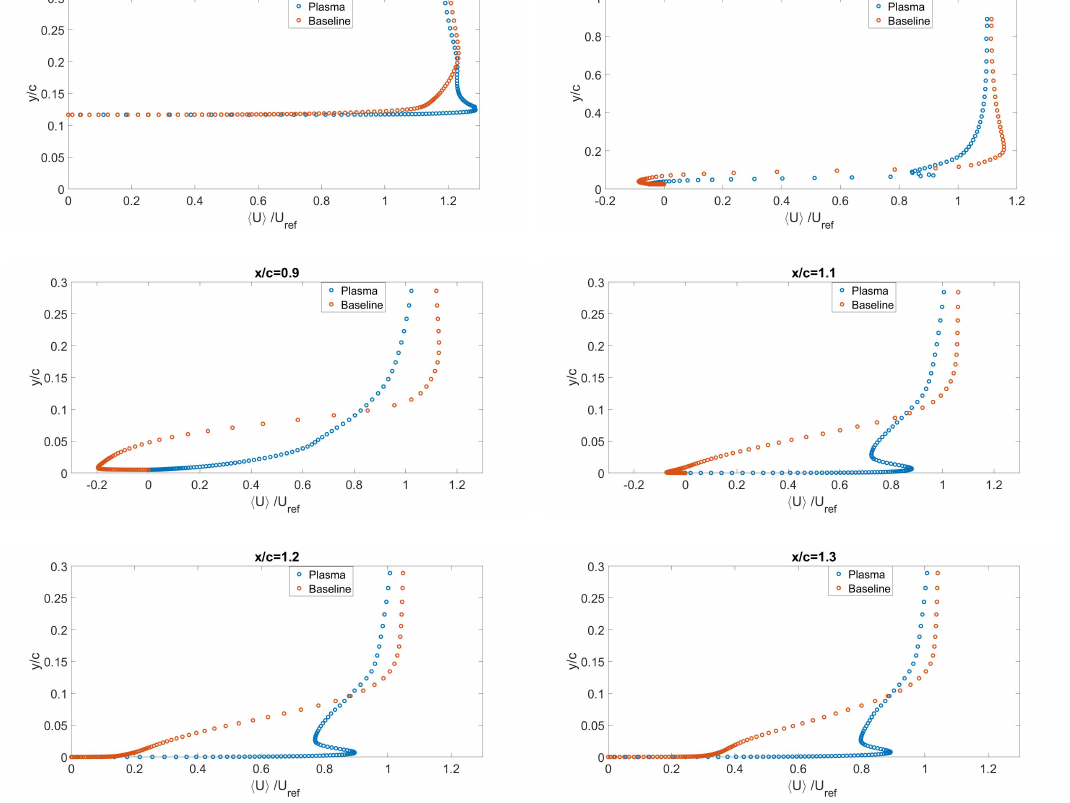
Figure 17. Normalized mean velocity comparisons along y / c at different streamwise